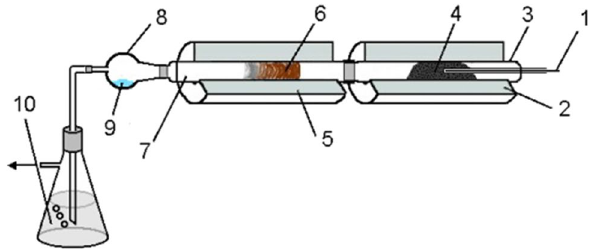
Table 1 Proximate analysis of coal samples